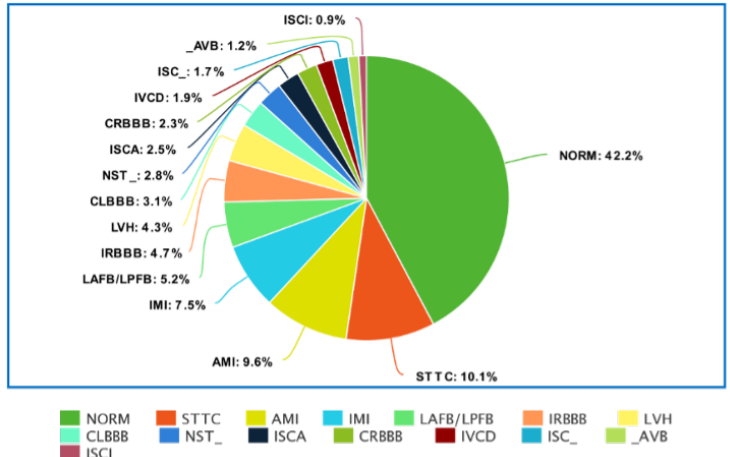
Figure 3. Distribution of PTB-XL database data by